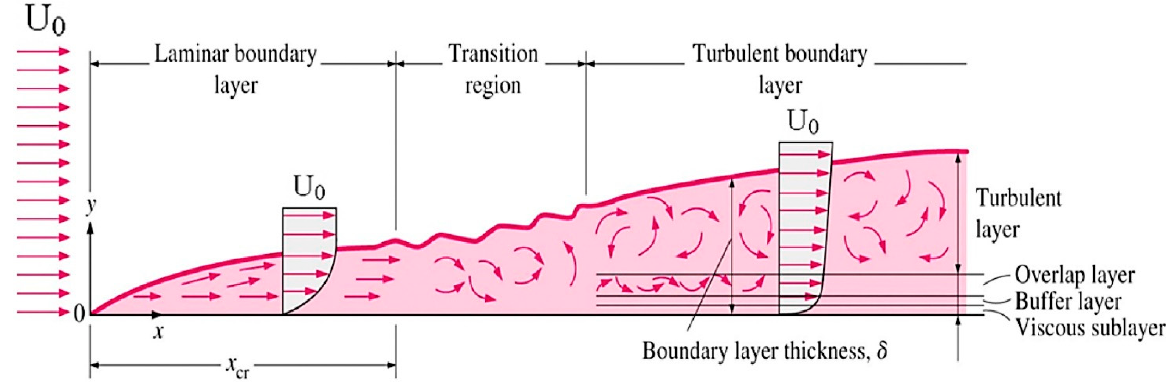
Figure 48. Different types of flows, adapted with permission from Ref. [150]. Copyright © 2017 Elsevier